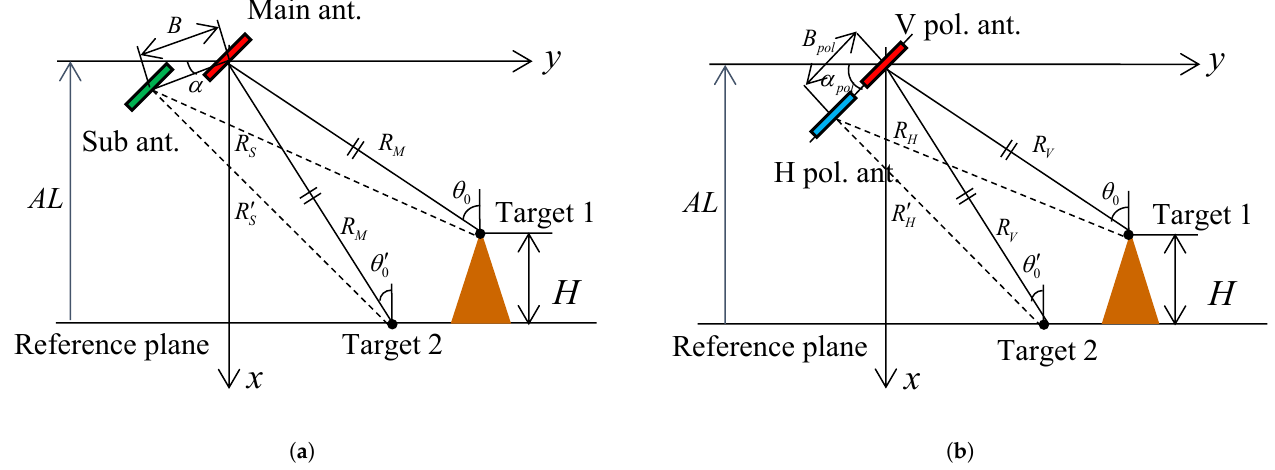
Figure 3. Observation geometric of Pi-SAR2. ( a ) Interferometric observation. ( b ) Polarimetric